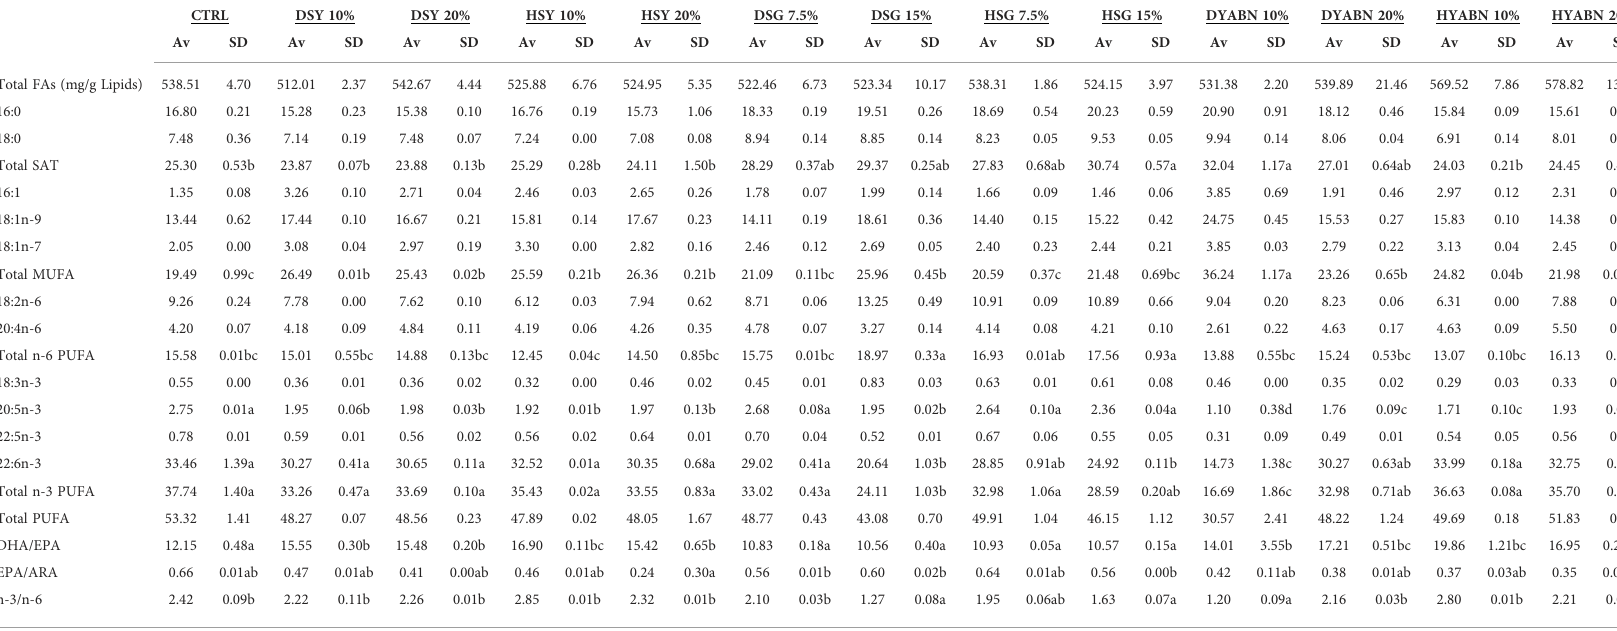
TABLE 8 Fatty acid composition (% of total FAs, only main fatty acids and totals are included) of the liver of the fi sh collected at the end of the trial. CTRL